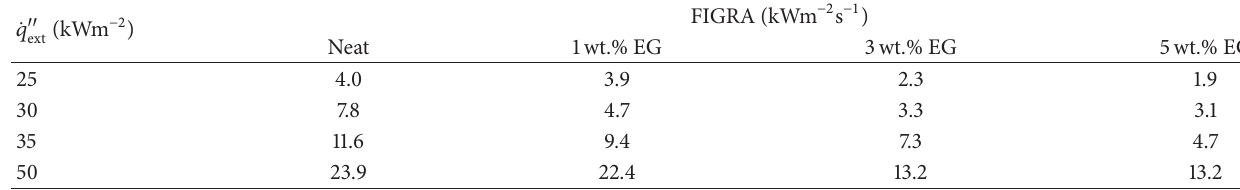
Table 2: FIGRA measured values of epoxy-EG composites from external heat fluxes.